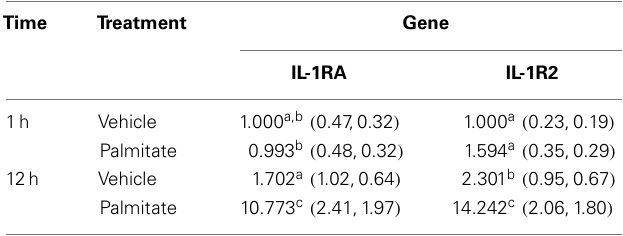
Table 4 | Effect of FFA treatment on liver gene expression